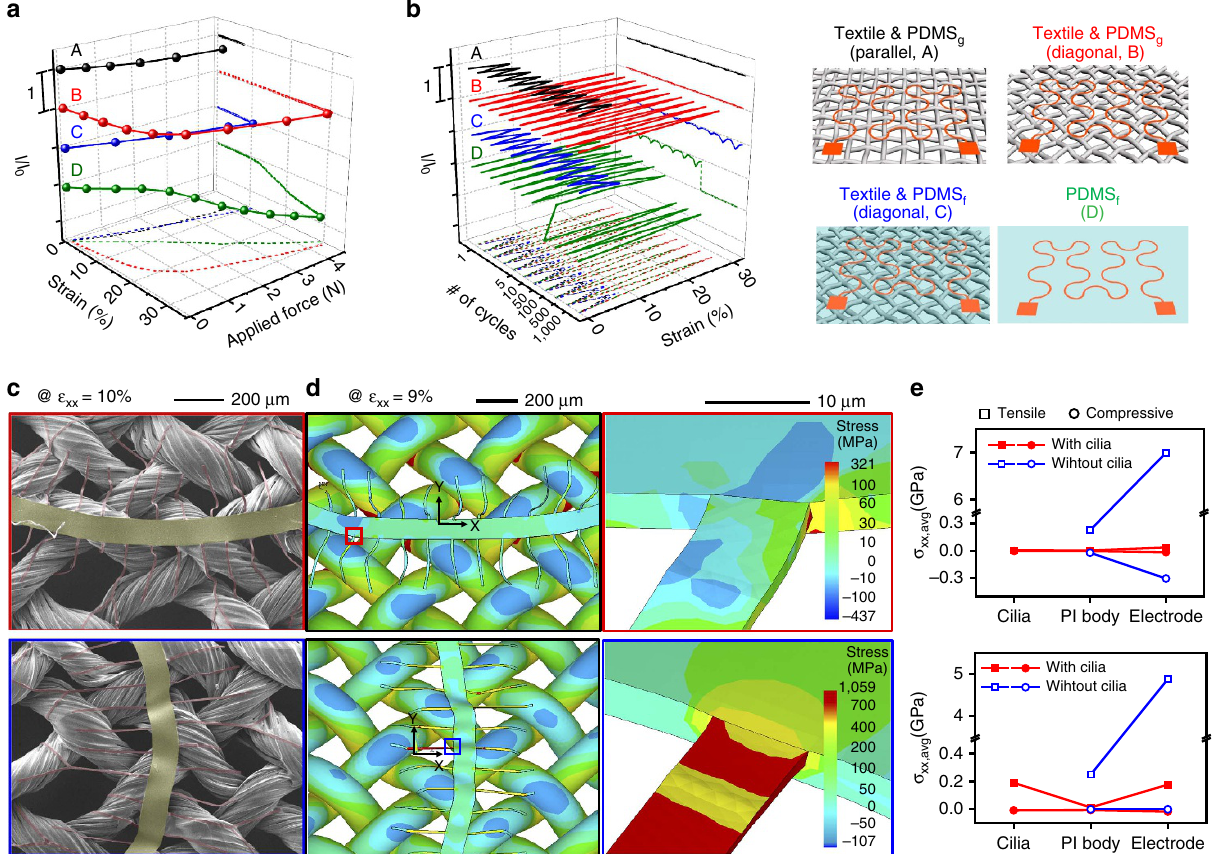
Figure 5 | Enhanced durability of electrodes upon stretching by cilia. ( a , b ) Strain–stress I / I 0 characteristics upon one-dimensional stretching ( a ) and electrical fatigue test upon repeated stretching up to B 3 ( ± 0.5) N(corresponding strains for samples A to D ¼ 6.8%, 28.5%, 8.5% and 25.6%, respectively) and releasing for 1,000 cycles ( b ) for four different samples. All encapsulated electrodes used in this test consist of PI (2 m m)/Cr (5nm)/Au (70nm)/PI (2 m m) with peripheral cilia (PI (1.8 m m)). The electrodes transferred onto textiles with two types of alignment (noted by parallel (A) and diagonal (B and C)) using 3 wt% PDMS glue solution in toluene. Sample C was prepared by an additional coating of PDMS film (total thickness ¼ 400 m m). Sample D was prepared by transfer printing on PDMS film followed by additional coverage of PDMS film (total thickness ¼ 500 m m). ( c ) SEM images of sample B in selected area placed on the textile parallel (top) and perpendicular (bottom) to the stretching direction ( x axis) at tensile strain e xx ¼ 10%. ( d ) Stress distribution maps for the sample B obtained by FEM simulation at tensile strain e xx ¼ 9%; the red and blue boxes correspond to the magnified stress distribution maps of the selected areas. ( e ) Average stress ( s xx,avg ) of each component of the sample B and the electrode without cilia, placed on the textile parallel (top) and perpendicular (bottom) to the stretching direction ( x axis), at tensile strain e xx ¼ 9%; for the case without cilia, the adhesion between the textile and main substrate is set to ideal bonding